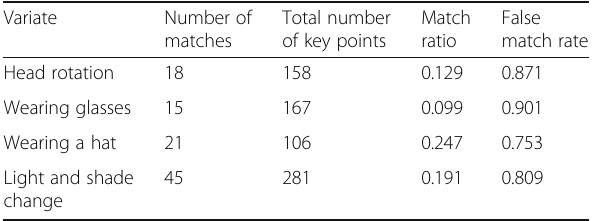
Table 1 Match result analysis table